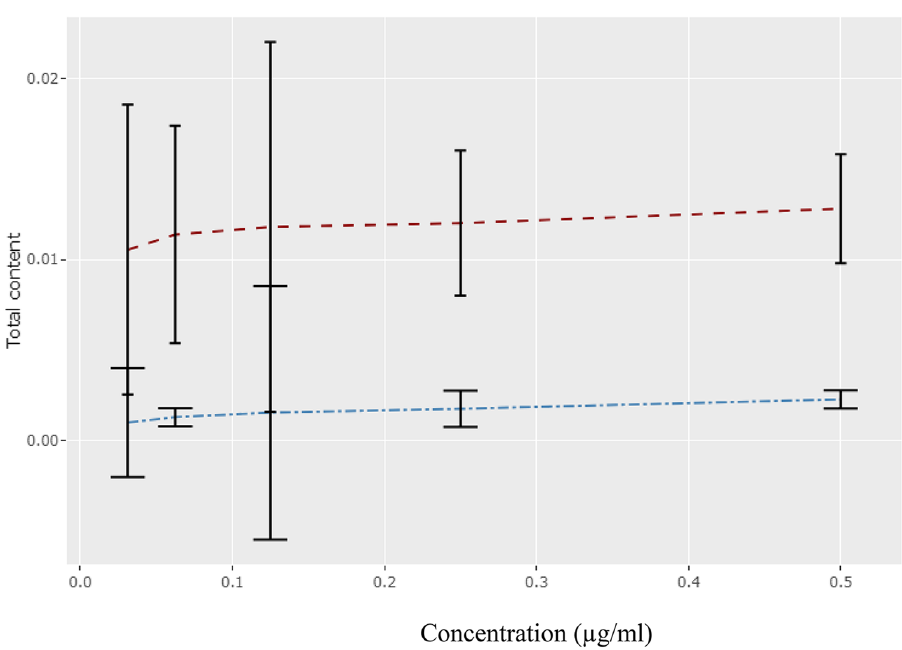
Figure 2. Correlation plot showing the concentration of the crude polyphenolic extract and total phenolic and total flavonoid